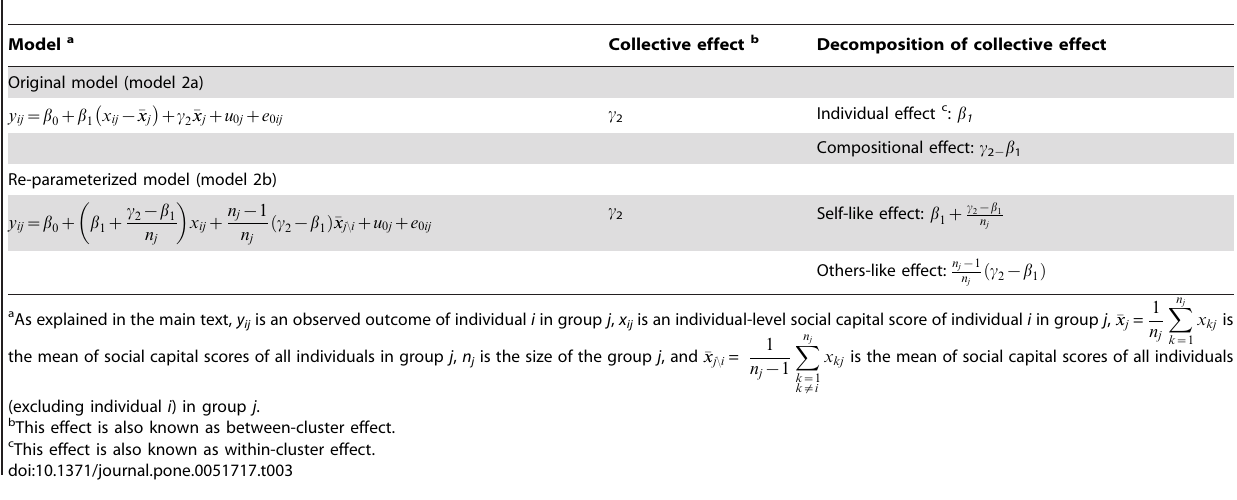
Table 3. Decomposition of effect of cluster-mean centered self-included model (2a) and its re-parameterized form (2b).